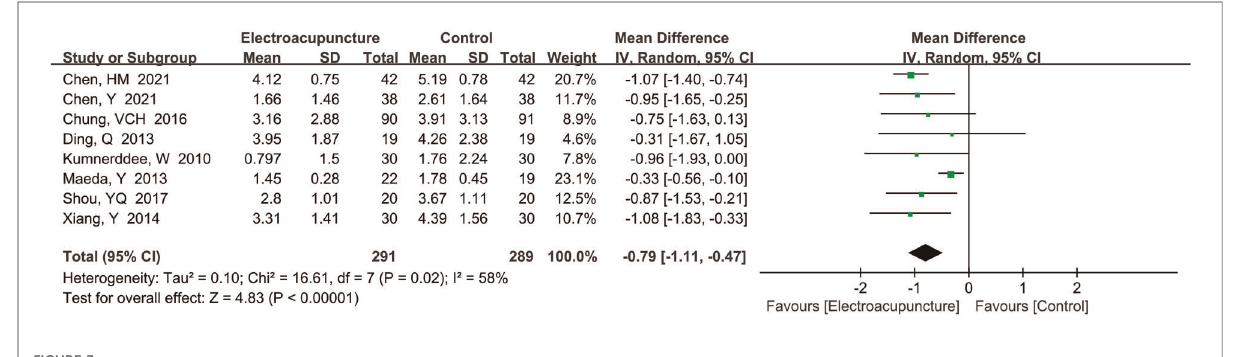
FIGURE 3 A forest plot showing the VAS score.